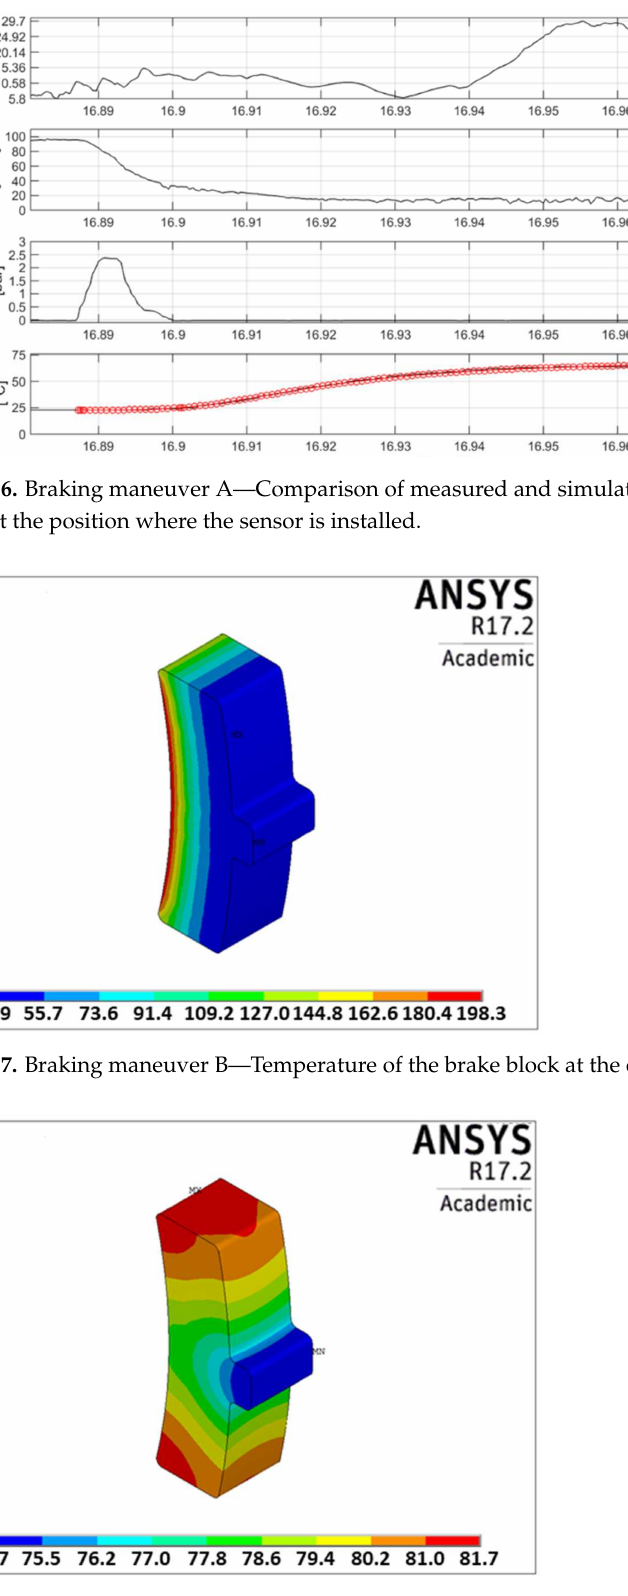
Figure 8. Braking maneuver B—Temperature of the brake block when the maximum temperature is reached at the position where the sensor is